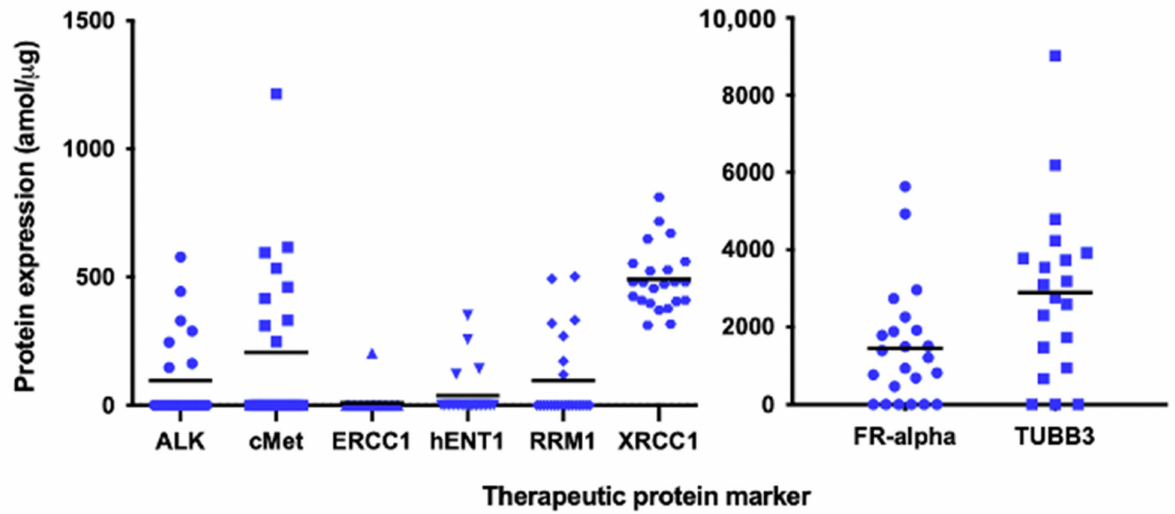
Figure 2. Scatter dot plot presents quantification of therapeutic protein expression by multiplexed, selected reaction monitoring assay. ALK, anaplastic lymphoma kinase. cMET, hepatocyte growth factor receptor. ERCC1, excision repair cross-complementation group 1. hENT1, human equilibrative nucleoside transporter 1. RRM1, ribonucleotide-diphosphate reductase M1. XRCC1, x-ray repair cross-complementing protein 1. FR-alpha, folate receptor alpha. TUBB3, tubulin beta-3 chain. Bar: mean.